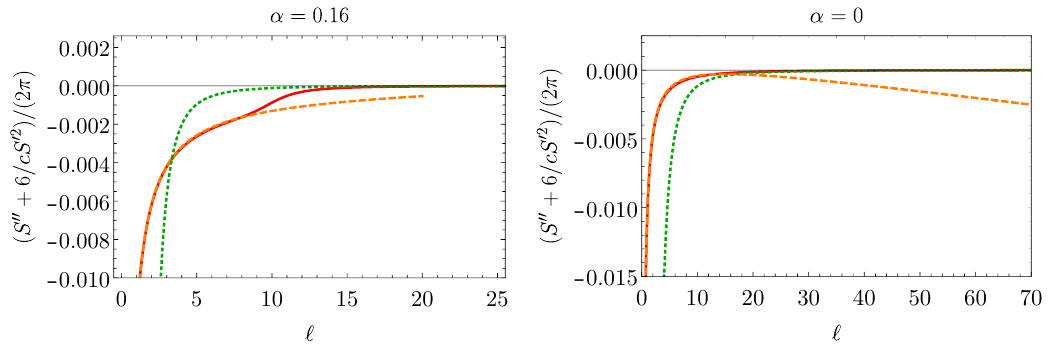
Figure 12 . QNEC 2 for the domain wall solution with α = 0 . 16 (left) and α = 0 (right). Red solid lines: numeric result for QNEC 2 . Orange and green dashed lines: perturbative results for small ‘ and large ‘ given in (6.1) and (6.3),